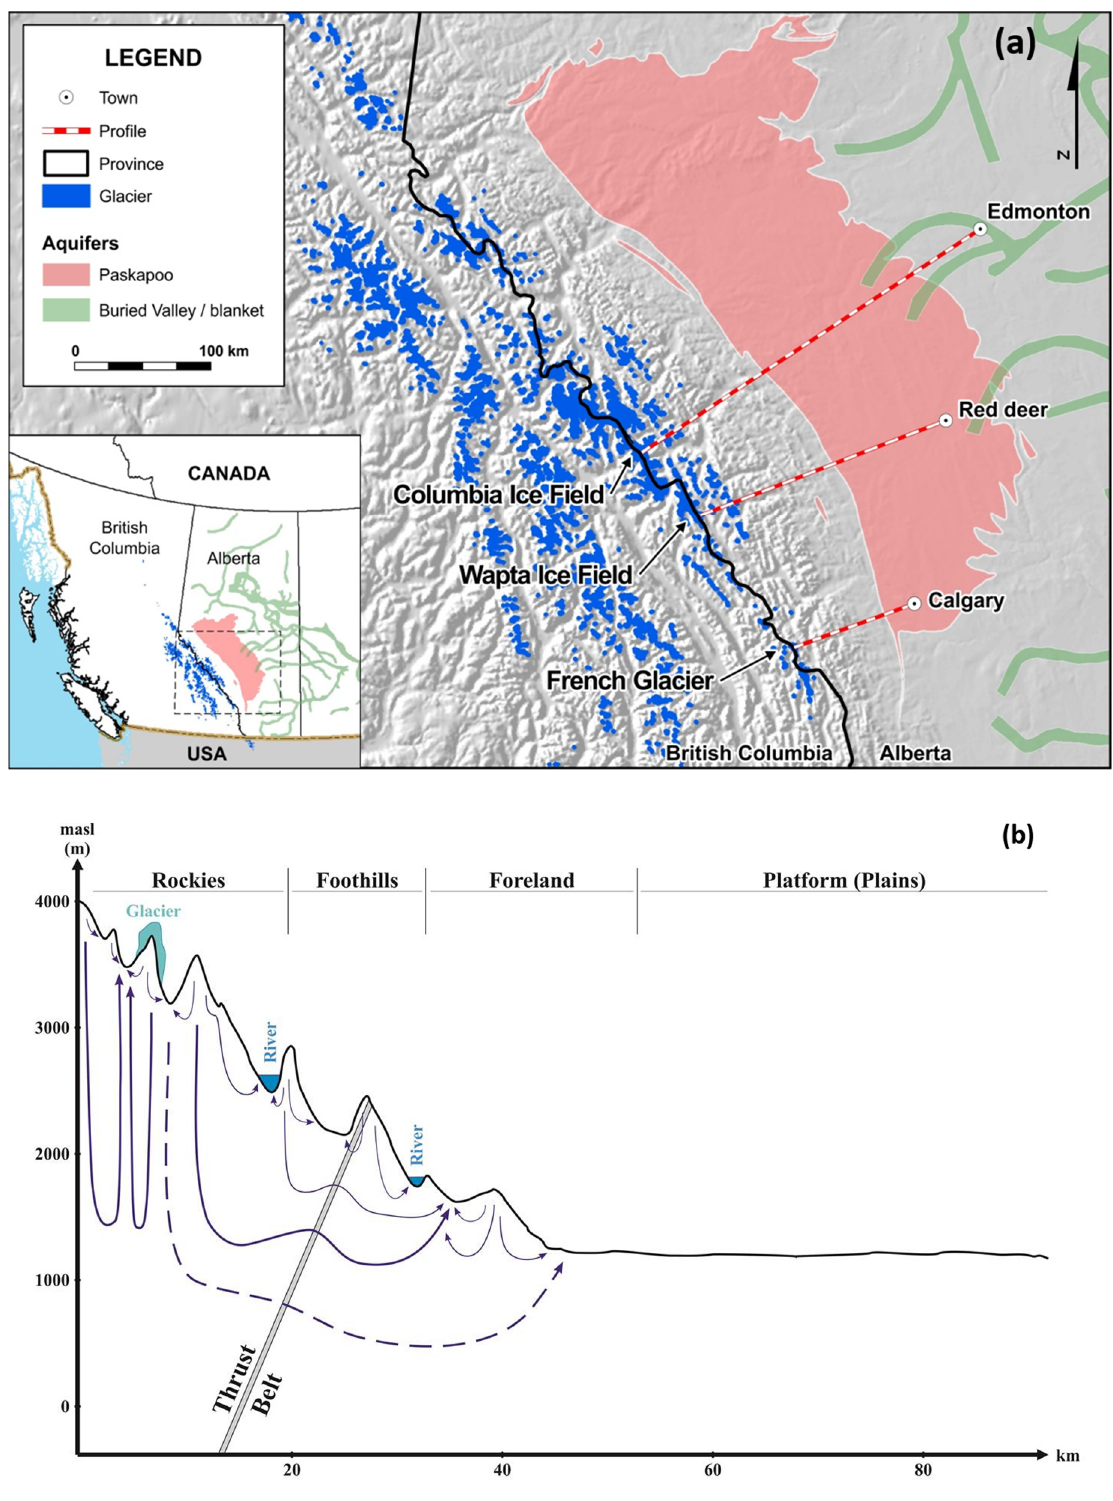
Figure 1. ( a ) Location of the study area; ( b ) conceptual generalized schematic cross-section with groundwater flow lines (vertical exaggeration = 13). groundwater flow lines (vertical exaggeration =